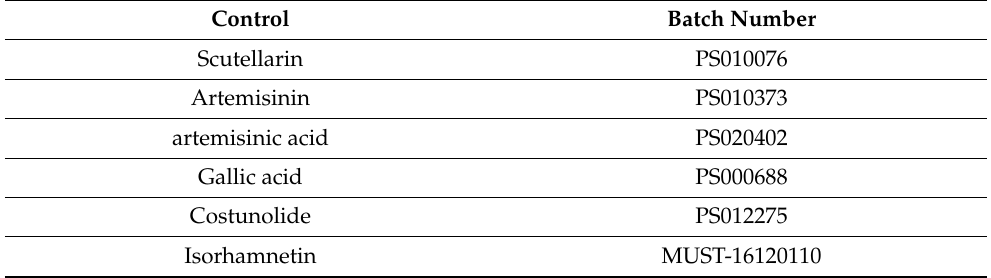
Table 6. Experimental reference substance and batch